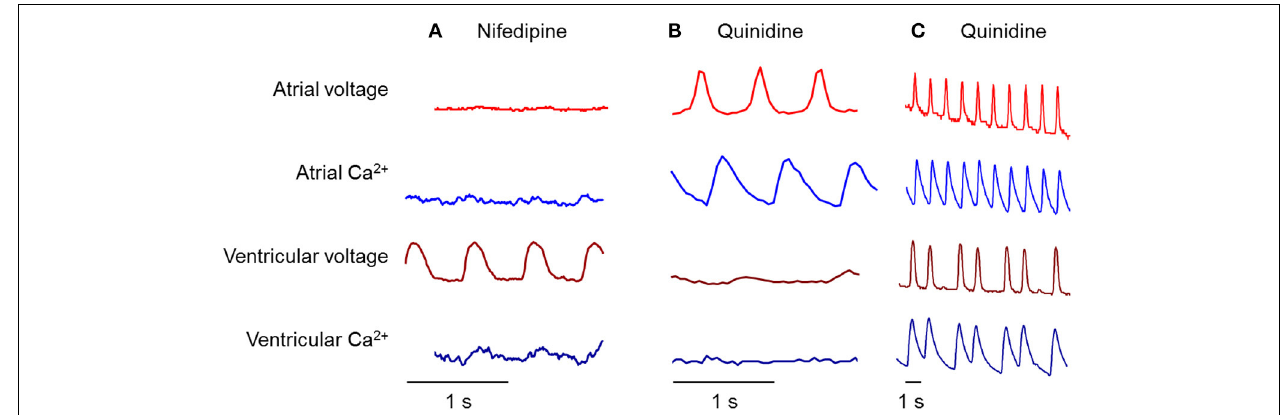
FIGURE 5 | Differential effects of nifedipine and quinidine on atrial and ventricular chambers at 90–102hpf. (A) Nifedipine, an L-type calcium channel blocker, largely suppressed calcium transients in both chambers, but only suppressed atrial voltage. (B) Quinidine, a blocker of the fast inward